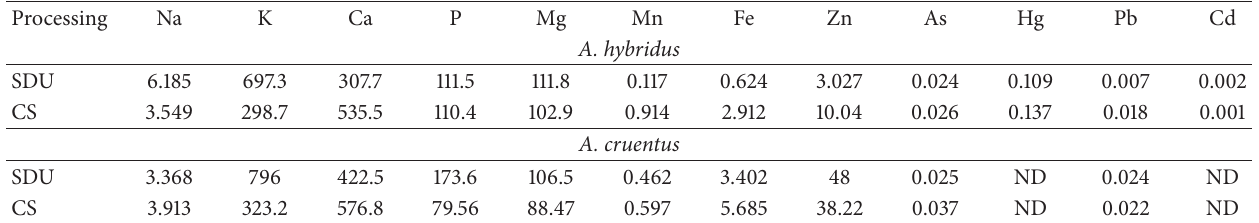
Table 2: Minerals and heavy metals composition (mg/Kg) of two differently processed amaranths species. Processing